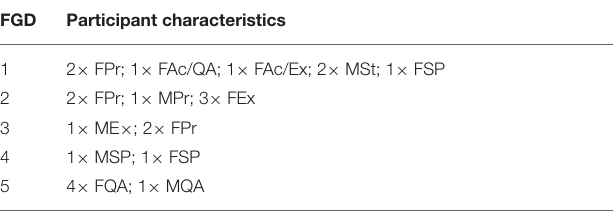
TABLE 2 | FGDs participant characteristics * . FGD Participant